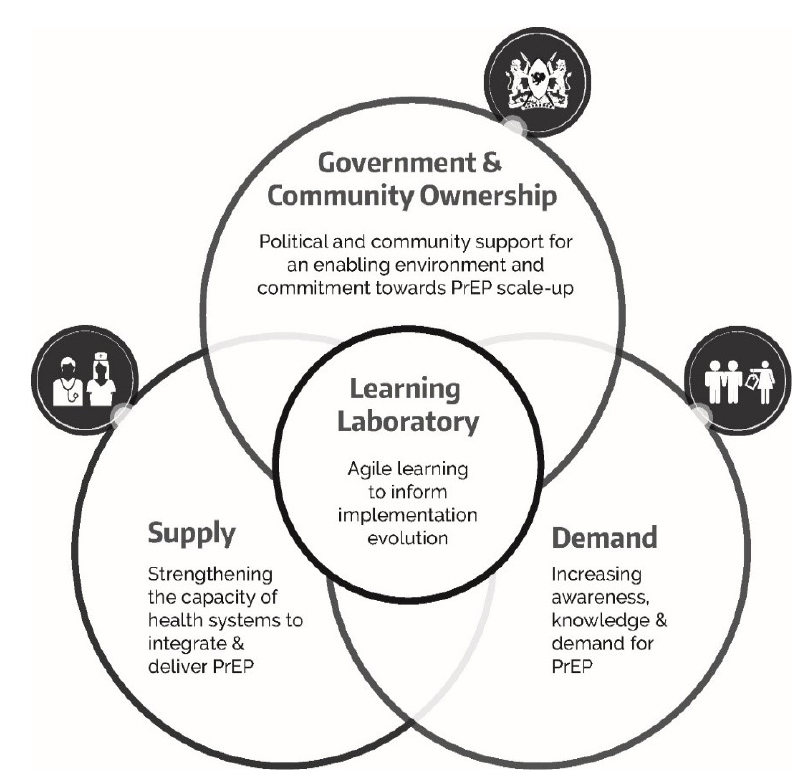
Figure 2. Jilinde’s framework for implementation of PrEP at scale in